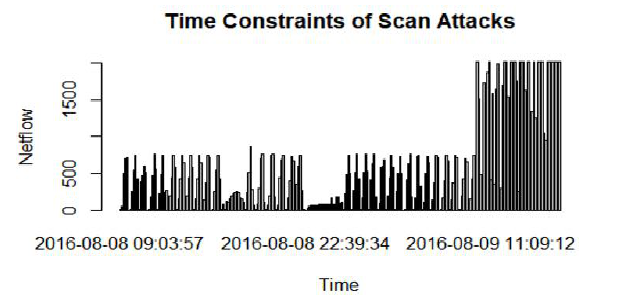
Figure 12. The timestamp fluctuation of the Scan malware.